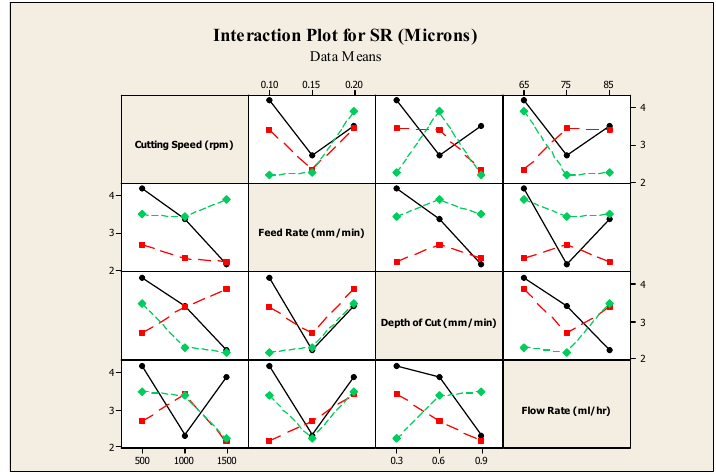
Figure 8. Interaction plot for surface roughness.